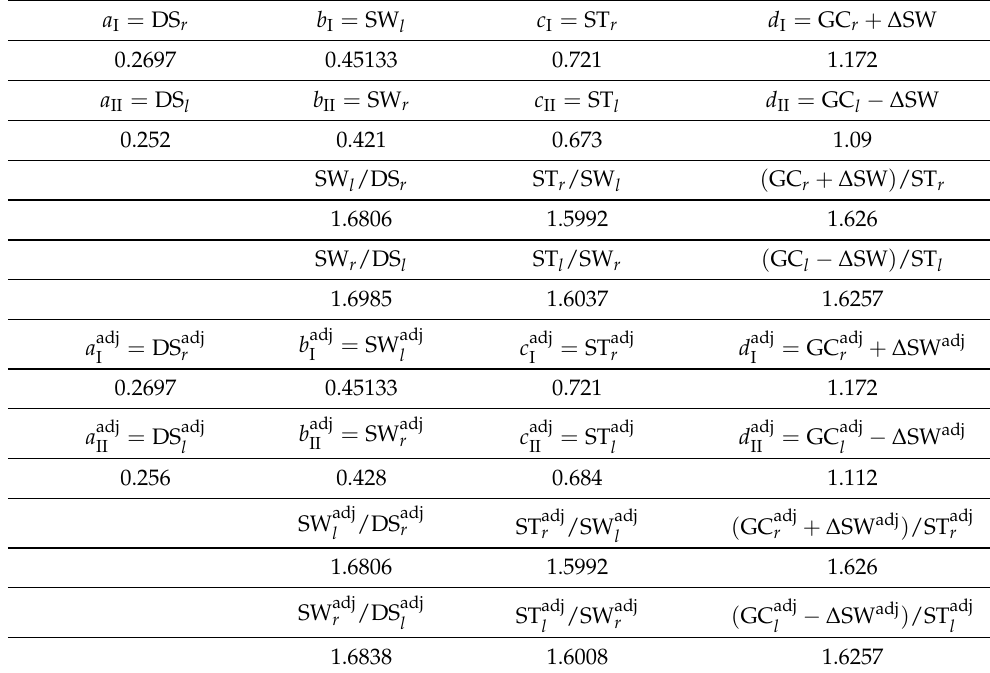
Table 4. Experimental data concerning the elements (in seconds) of the sequences I and II in (3) and their adjoint versions I adj , II adj in (4) for the healthy subject 1 (DS x = 0.12967 s, DS y = 0.14 s).